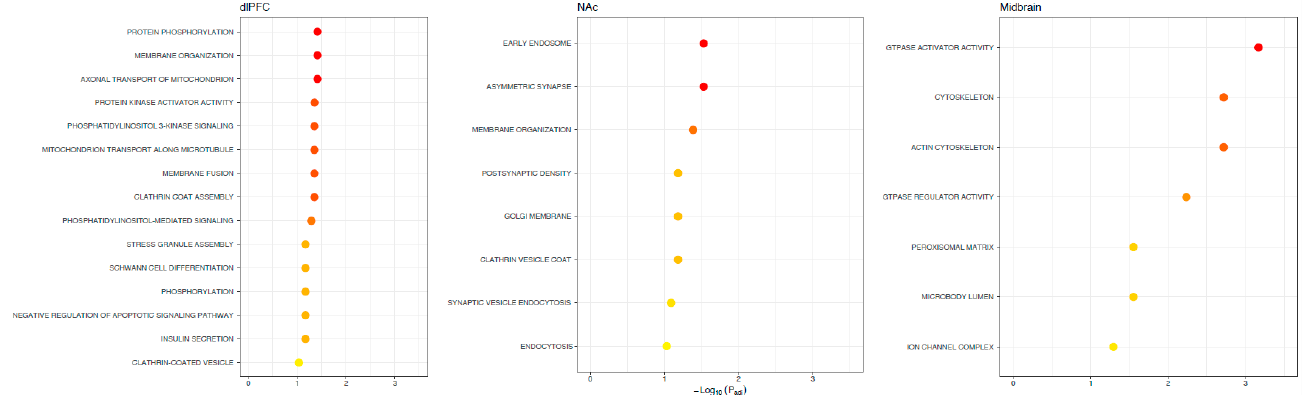
Figure 2. Functions of alternative splicing associations with OUD across brain regions. Possible functions of differentially spliced genes associated with OUD. The X-axis denotes the level of significance and the y-axis shows the different gene ontology terms (KEGG pathways, biological processes, molecular functions, and cellular components). Note no significant (FDR < 0.1) gene ontology terms were linked across all brain regions, highlighting regional specificity.